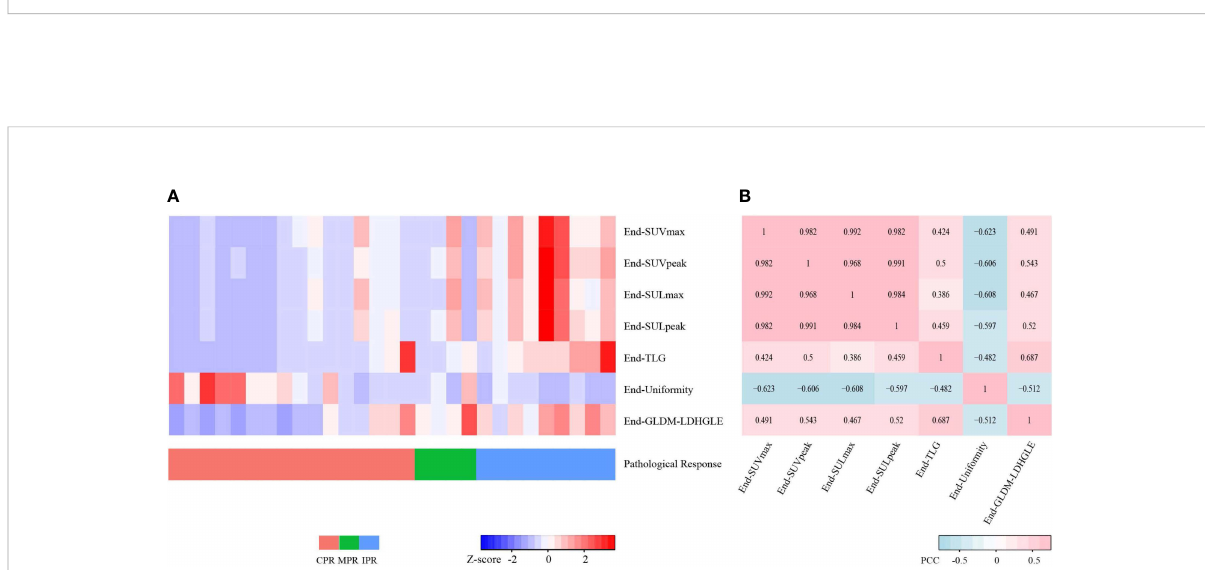
FIGURE 6 Heatmaps for seven preoperative PET features. (A) Heatmap shows the Z-scores of the seven preoperative PET features of 29 cases and corresponding pathological responses. (B) Heatmap shows the Pearson Correlation Coef fi cient (PCC) values of the seven preoperative PET features. CPR, complete pathological response; MPR, major pathological response; IPR, incomplete pathological response.